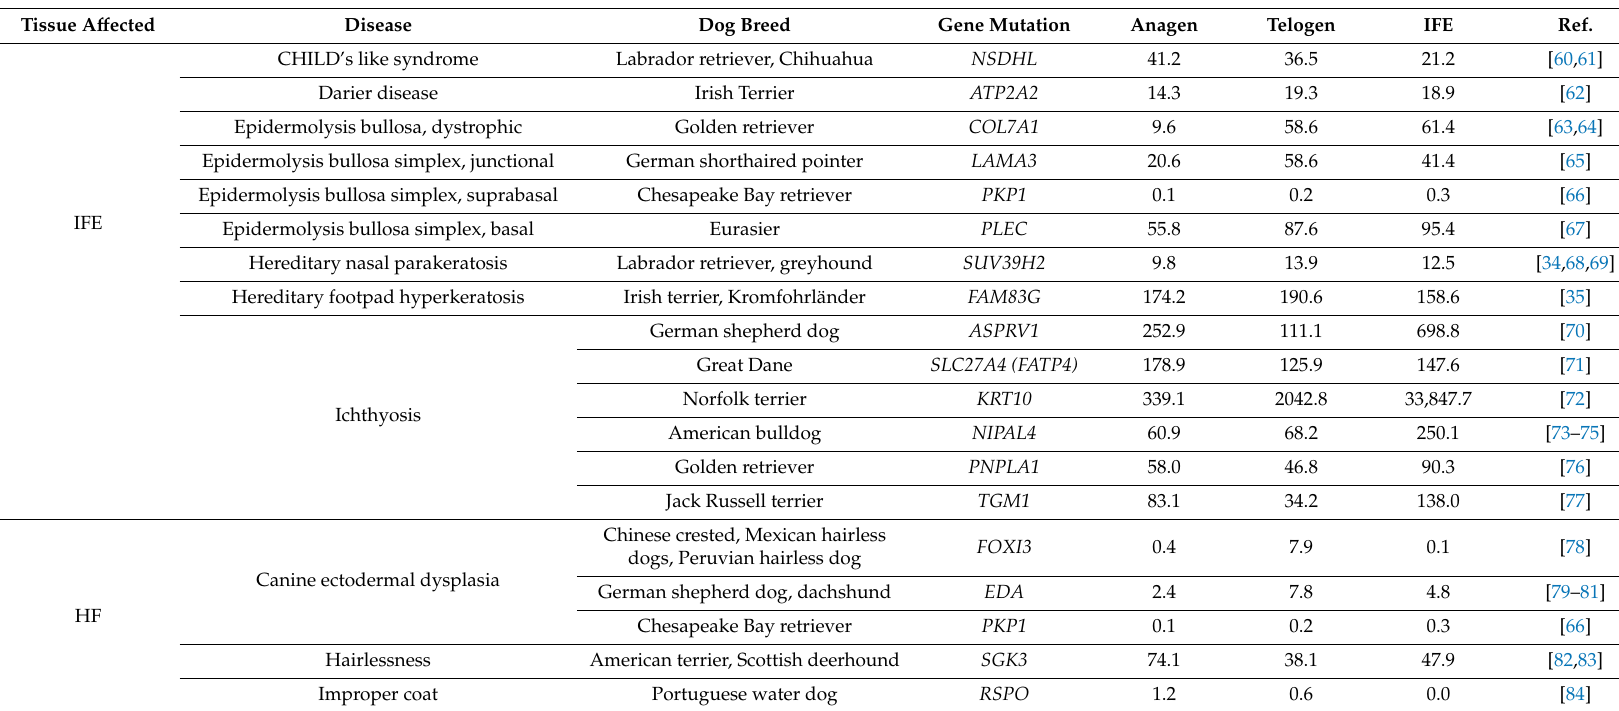
Table 2. Expression of genes associated with canine genodermatoses. Genes that are associated with a genetic variant leading to epidermal or follicular disease or phenotype are listed and the expression levels based on the average TPM normalized values in telogen, anagen and interfollicular epidermis samples are